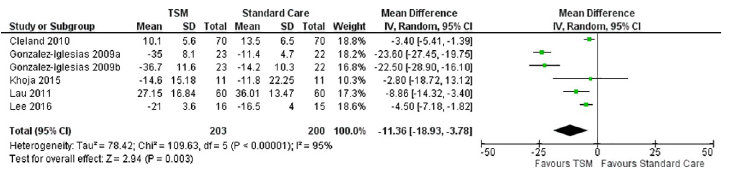
Fig 8. Meta-analysis for TSM versus standard care for disability at short-term follow-up.